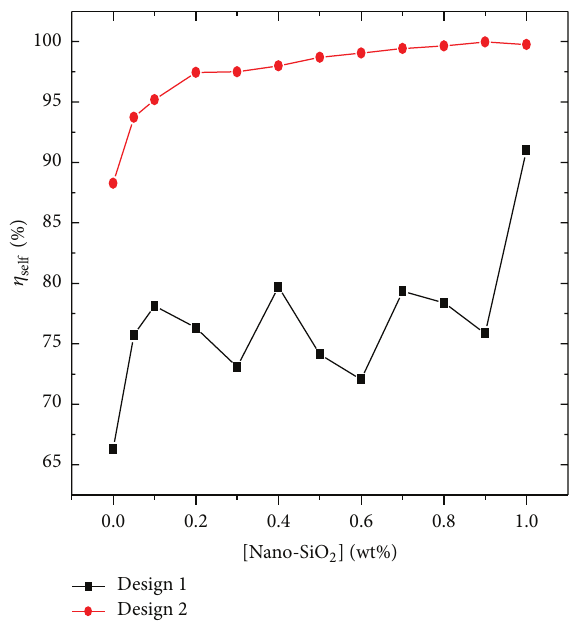
Figure 9: The dependence of self-absorption efficiency, 𝜂 nanosilica concentration for TLSC